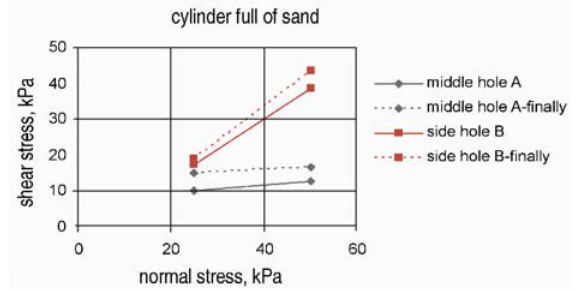
Fig 15 . Distribution of horizontal component of σ during test of fine granite crushed stone stress x